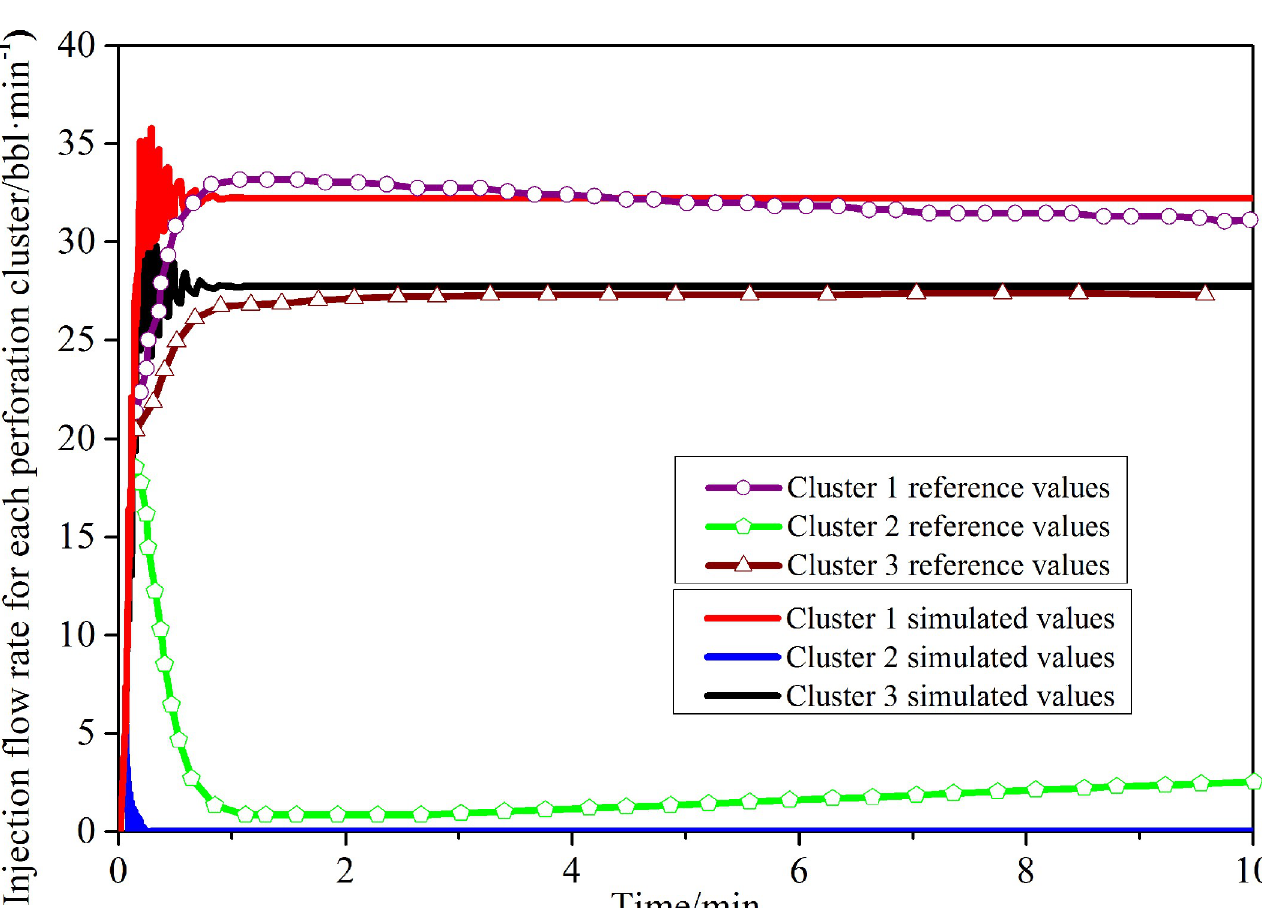
Fig 5. Comparison of simulation with reference results.